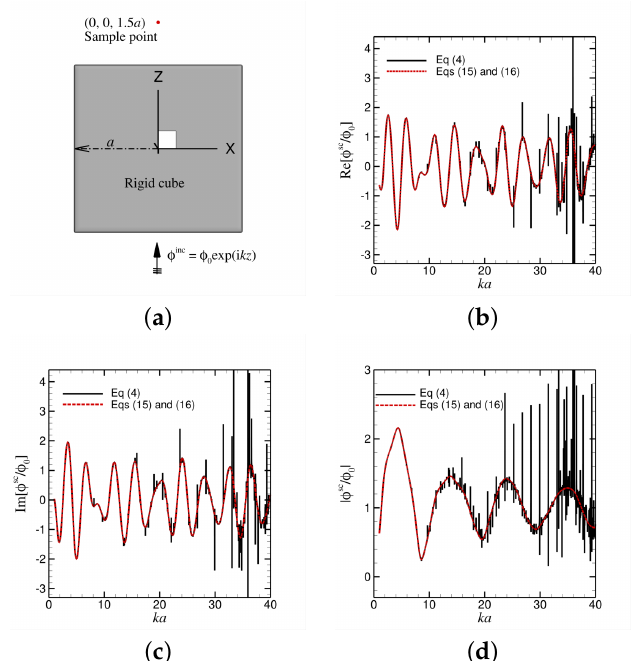
Figure 4. Scattering on a rigid cube with sides of length 2 a used as a test case. ( a ) The incoming plane wave moves upwards and the observation point is behind the cube at a distance of 1.5 a from the centre of the cube. ( b ) The results of the real part of the potential φ sc , with the non-singular Burton–Miller formulation (in red) as a function of ka . The results of the non-singular standard boundary element method are also indicated (in black). More and more spurious ‘spikes’ appear when ka becomes larger and larger. The number of nodes used is 11,642 with 5820 quadratic triangular elements. ( c , d ): as ( b ) but for the imaginary part of φ sc and the absolute value of φ sc , respectively. As in Figure 2, the desingularized Burton–Miller results (red curves) are perfectly regular for all values of ka